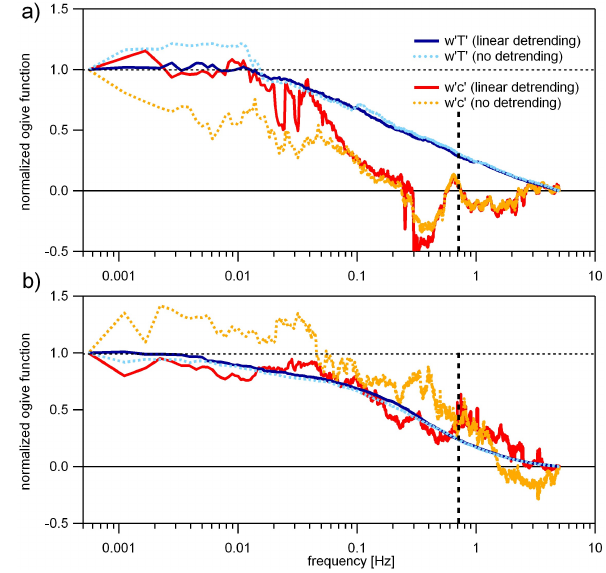
Fig. 1. Normalized ogive functions of vertical wind vs. sonic tem- perature ( w 0 T 0 , blue) and vertical wind vs. aerosol number con- centration ( w 0 c 0 , red). (a) Median ogives from 20 August, 01:00– 04:00. (b) Median ogives from 24 August, 03:30–07:30. Broken lines in light colors show ogives without linear detrending. Verti- cal dashed lines indicate the frequency corresponding to the CPC response